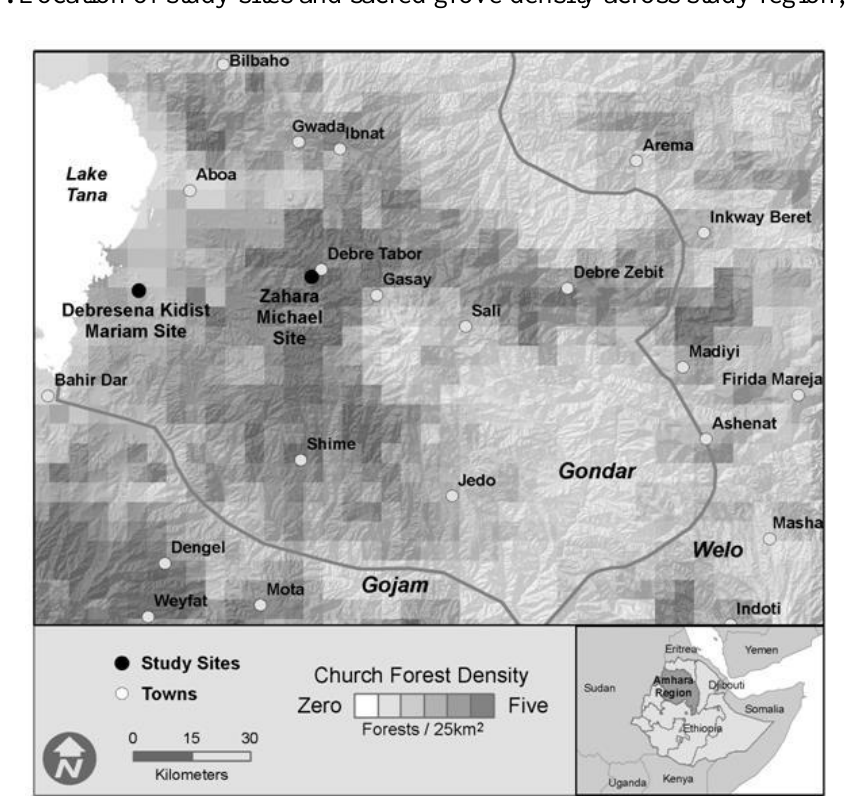
Figure 1. Location of study sites and sacred grove density across study region,